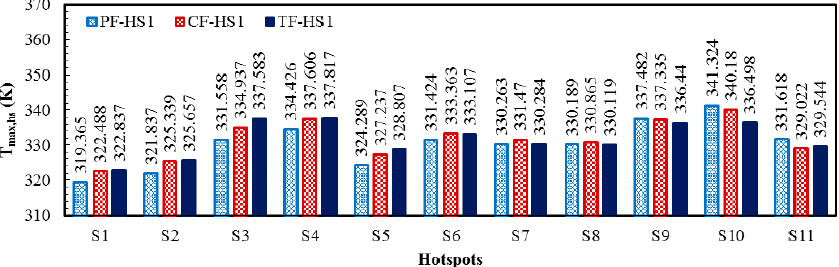
Figure 8. Maximum temperatures at the hotspots of PF, CF, and TF heat sinks with the hotspot scheme HS1 at the total flow rate of 0.01 kg/s.